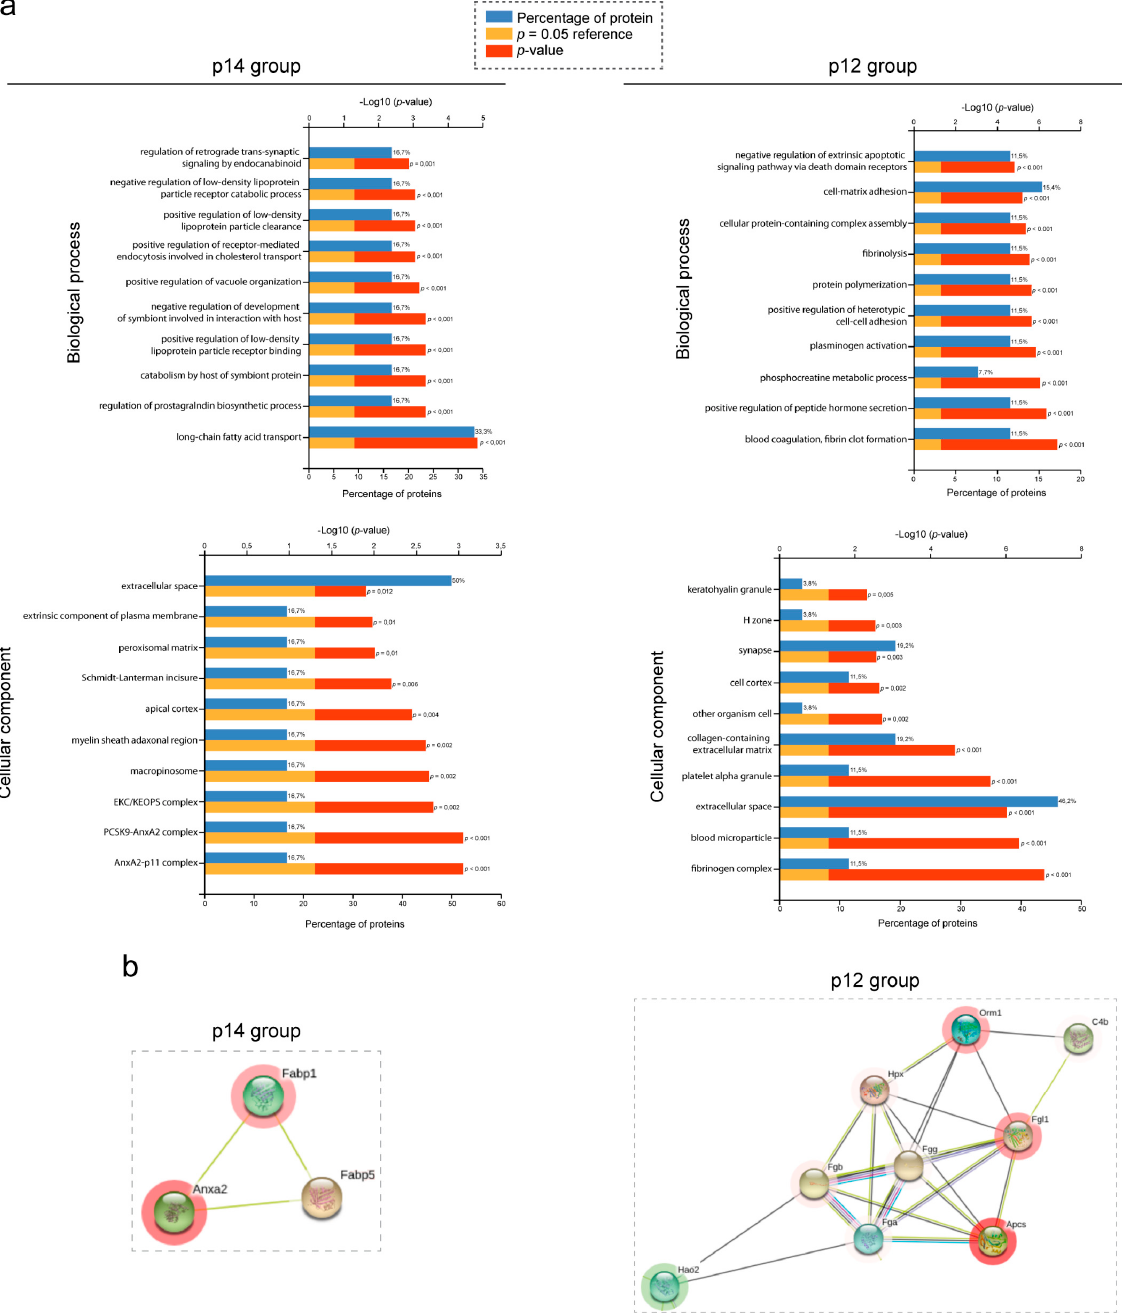
Figure 4. Functional analysis of PLD proteome. ( a ) FunRich functional enrichment analysis results. Proteins identified with proteomic quantified SWATH analysis in each group, p14 (left panel) and p12 (right panel), were submitted to biological process (upper panel) and cellular component (lower panel) in FunRich software. For all graphs, upper X ‐ axis represents − Log10 ( p ‐ value) and lower X ‐ axis represents the percentage of proteins. The highest FDR and p ‐ value top 10 process and components are shown, which were classified according to their p ‐ value (down the lowest p ‐ value). ( b ) Protein–protein interaction map of selected clusters according to string. Proteins with significant up ‐ and down ‐ regulated protein abundance were submitted to string analysis. Networks represent protein–protein analysis of selected and the most important clusters of p14 ( right ) and p12 ( left ) data, respectively. Proteins are represented as nodules, which are colored red or green imply up ‐ regulate or down ‐ regulate in protein abundance respectively.